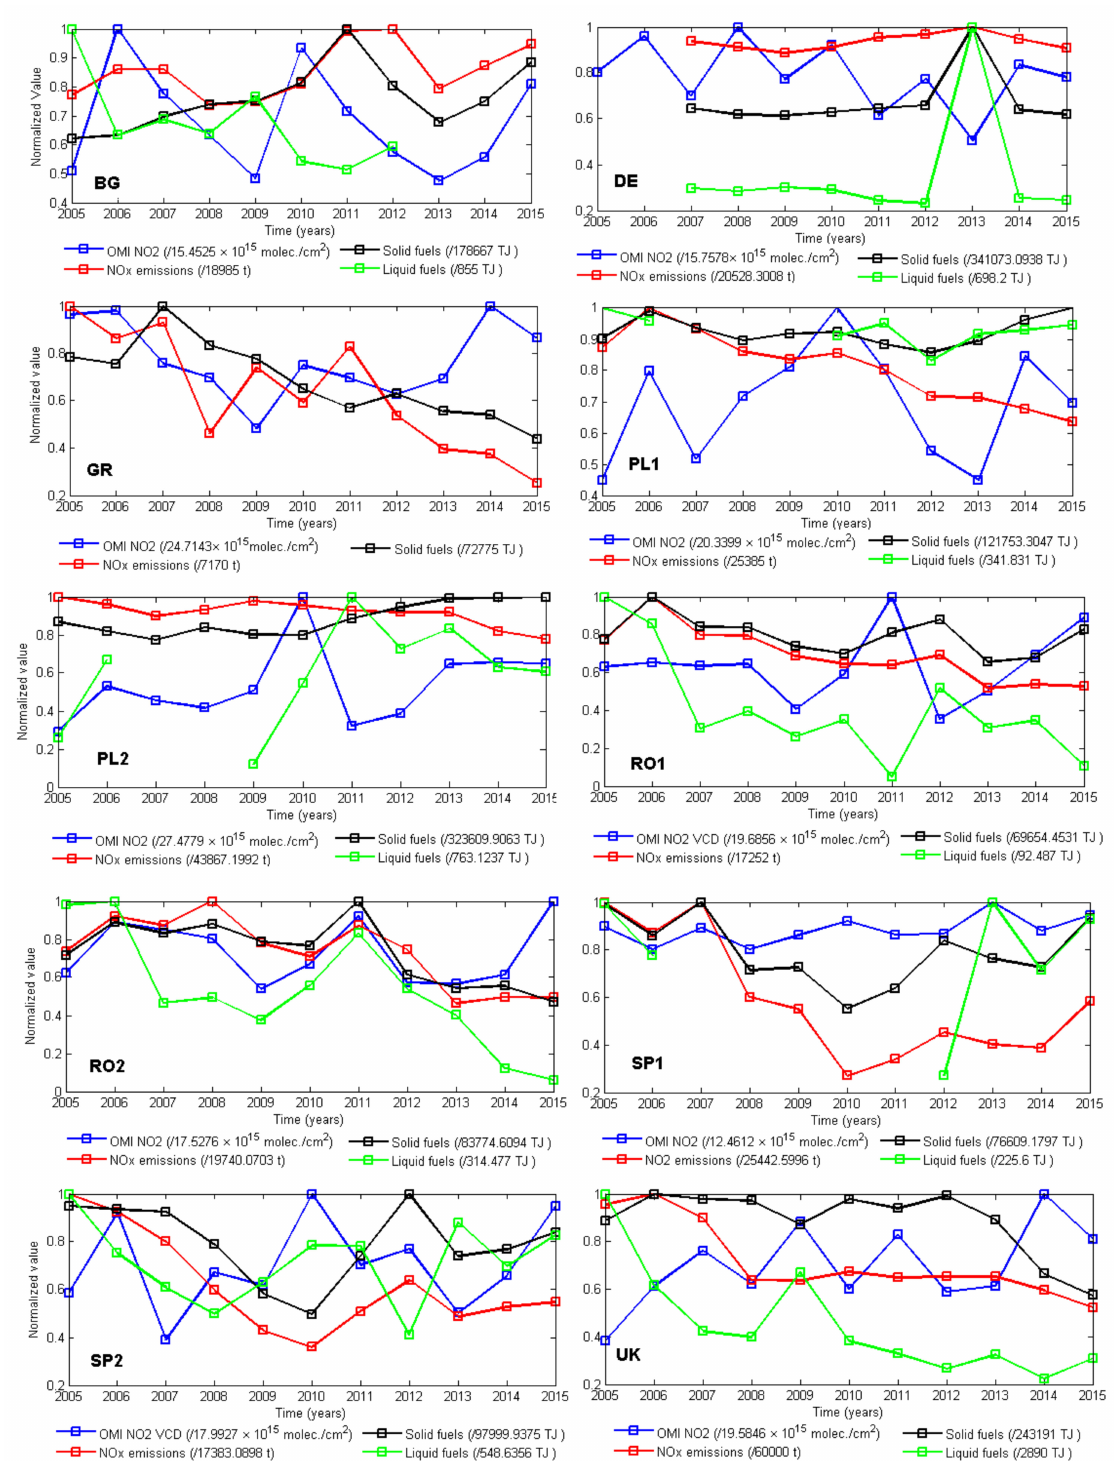
Figure 5. Time series of normalized NO 2 during 2005–2015 using data from satellite instruments (blue) and emissions (red) for each station, together with the reported solid fuel (black) and liquid fuel consumption